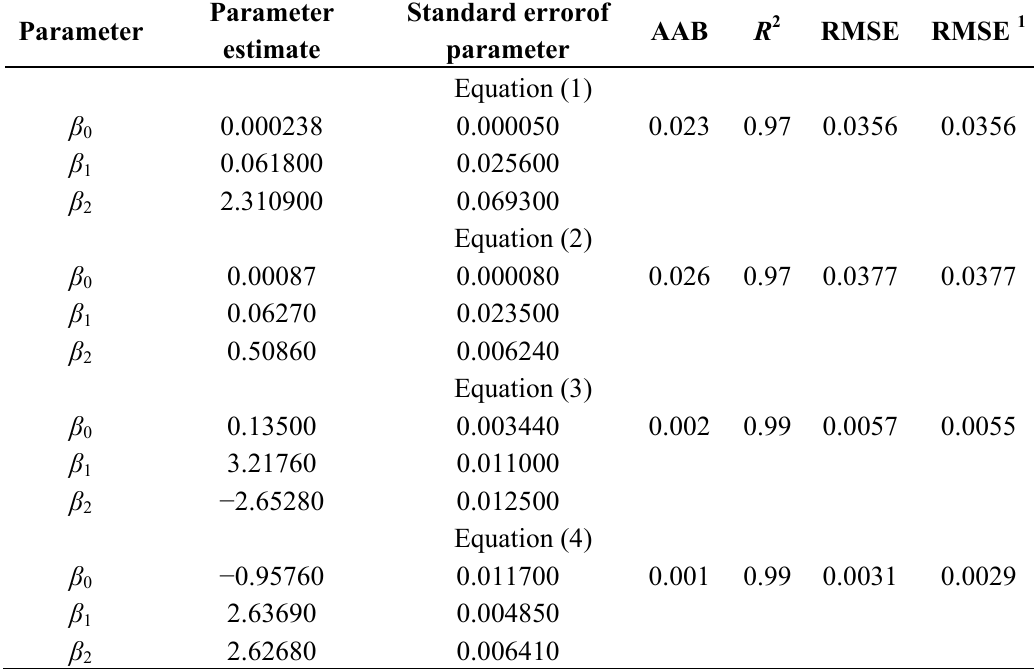
Table 2. Estimated parameters of Equations